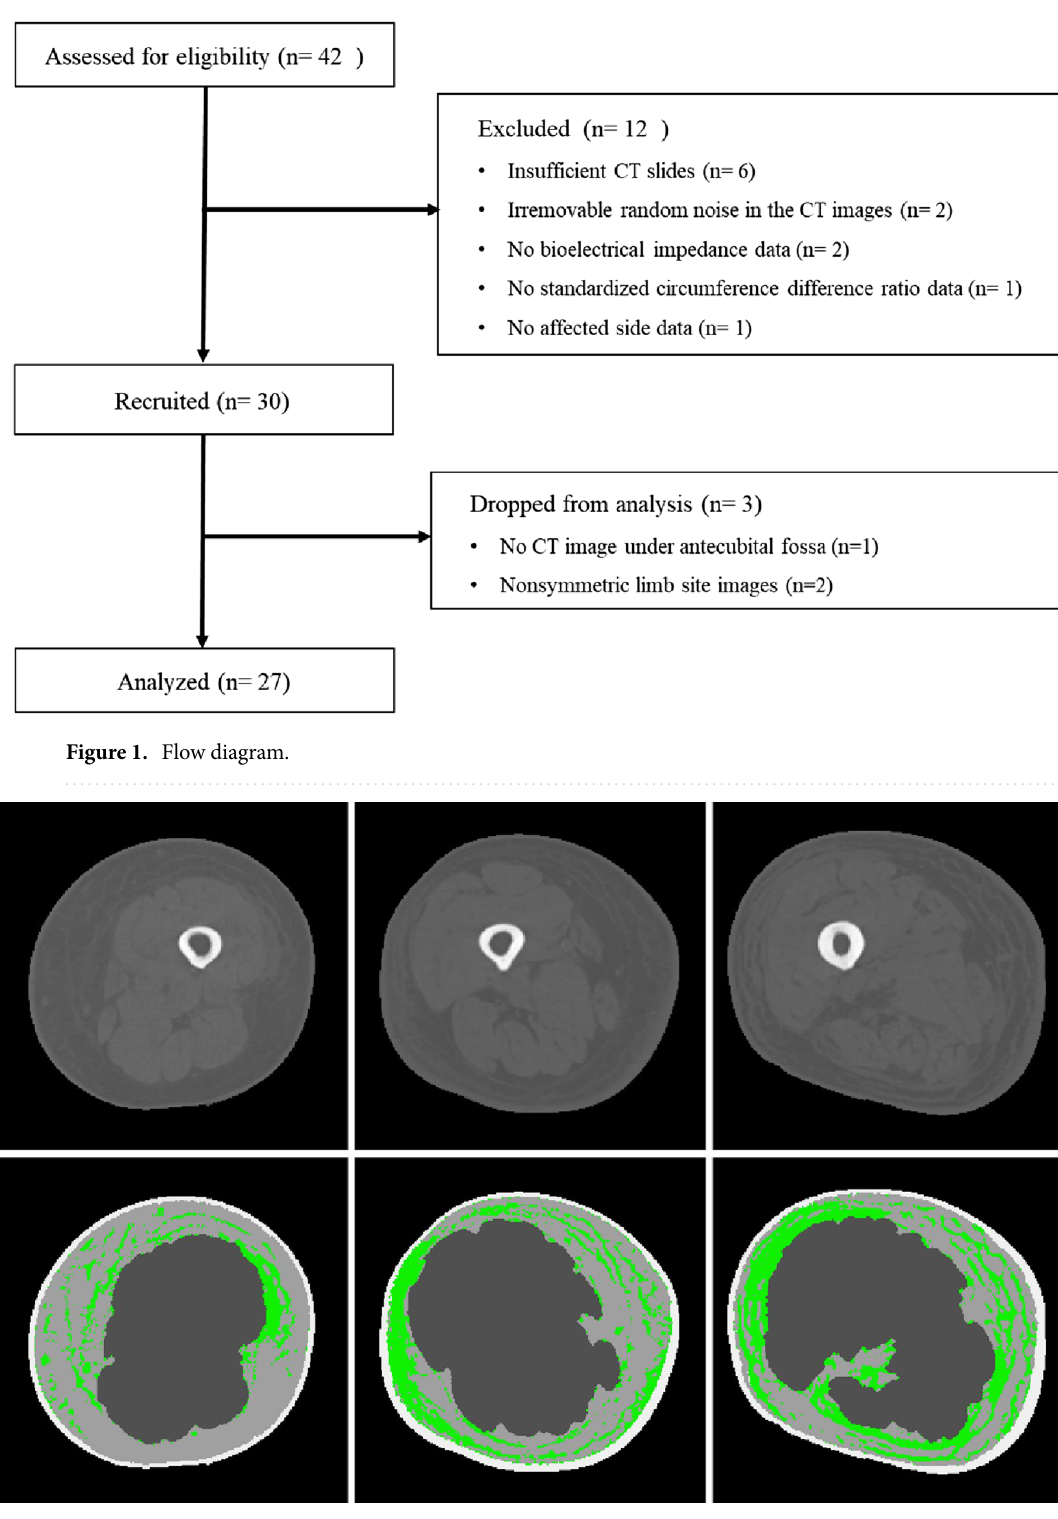
Figure 2. Original CT images (upper row) and images labeled using the lab-developed GUI (lower row). The pixels classified as fibrosis are marked in